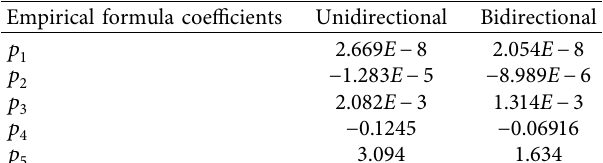
Table 6: Empirical formula coefficients of P − f characteristic curves.